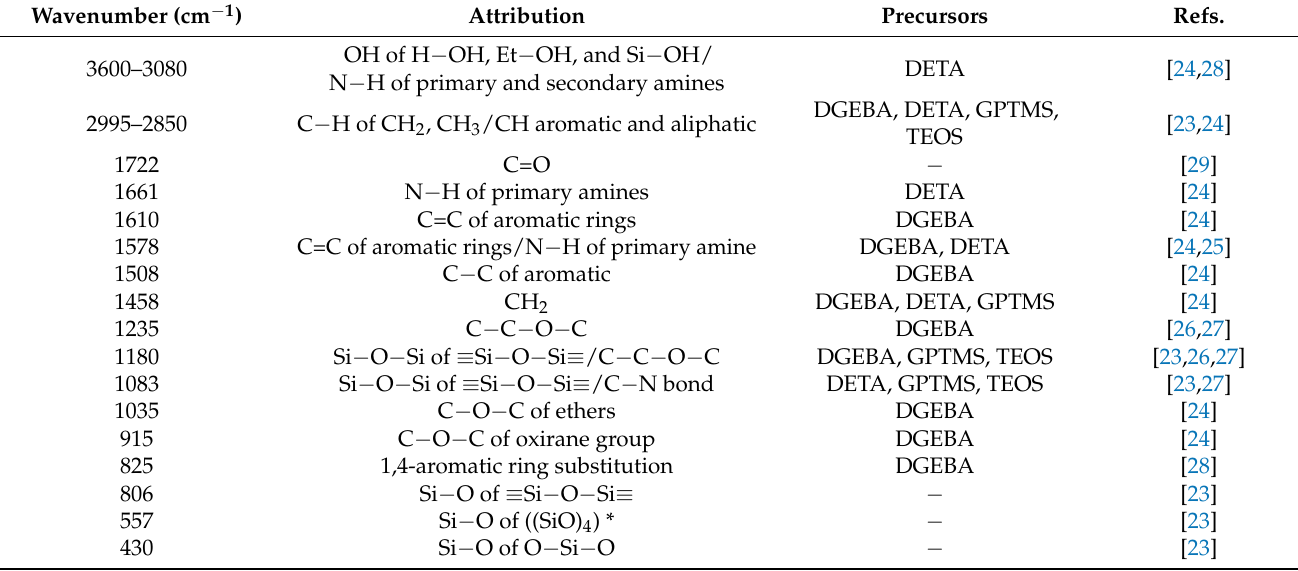
Table 2. Characteristic bands of epoxy–silica hybrids and precursor